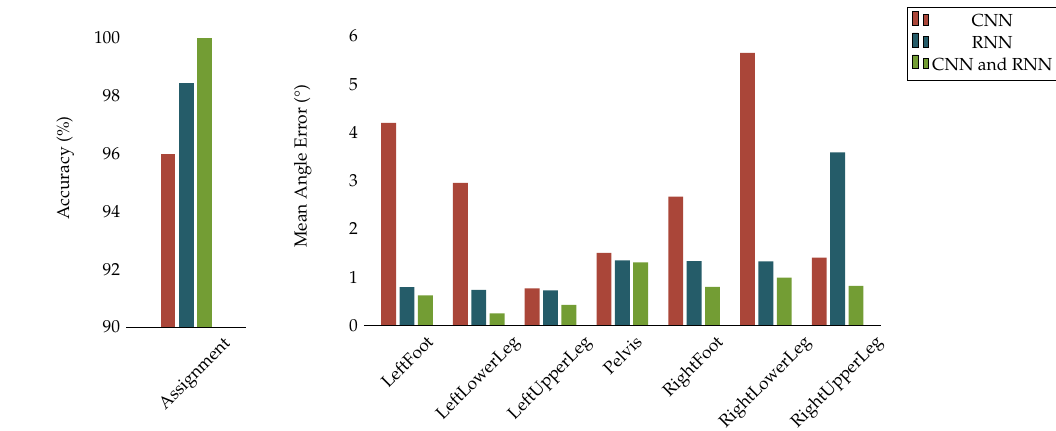
Figure 9. Network configuration cross validation on dataset A : (Left) The bar plot represents the accuracy of the I2S assignment problem; and (Right) the bar plots represent the mean angle errors over all axes and windows for the I2S alignment problem for each body segment.